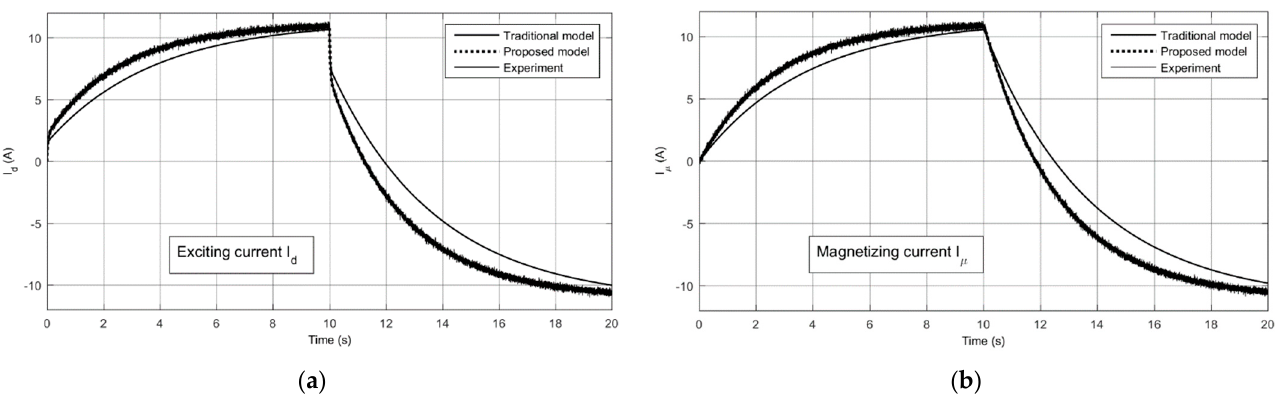
Figure 13. Results of simulation and experimental. ( a ) Exciting current of generator; ( b ) Magnetizing current of generator